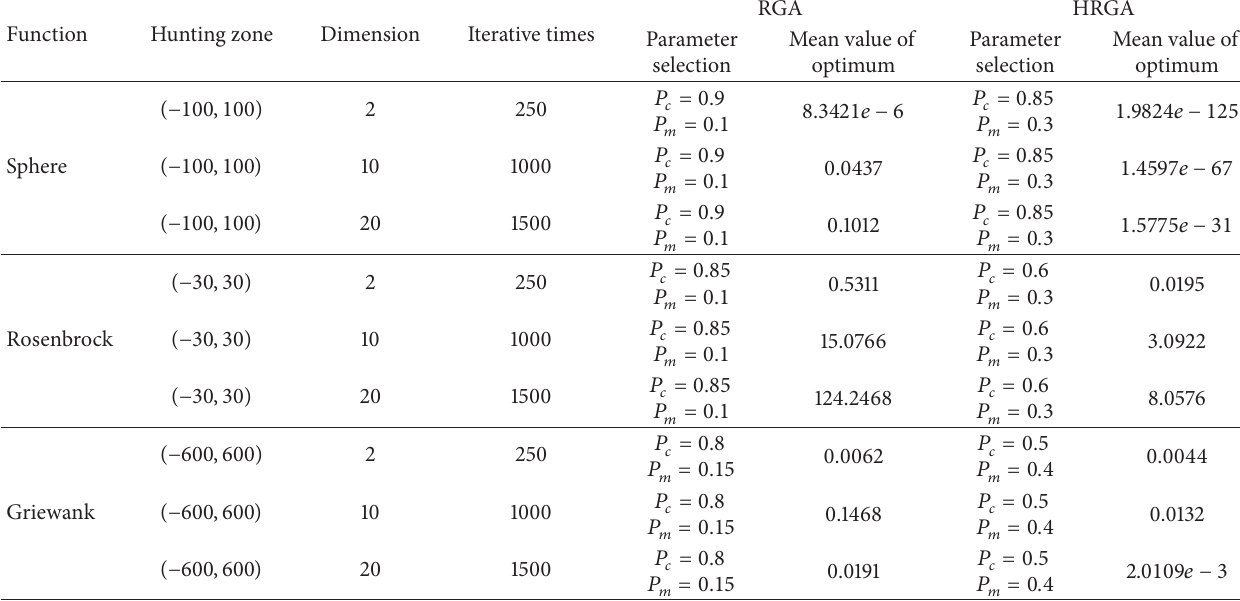
Table 2: Testing results of HRGA and standard